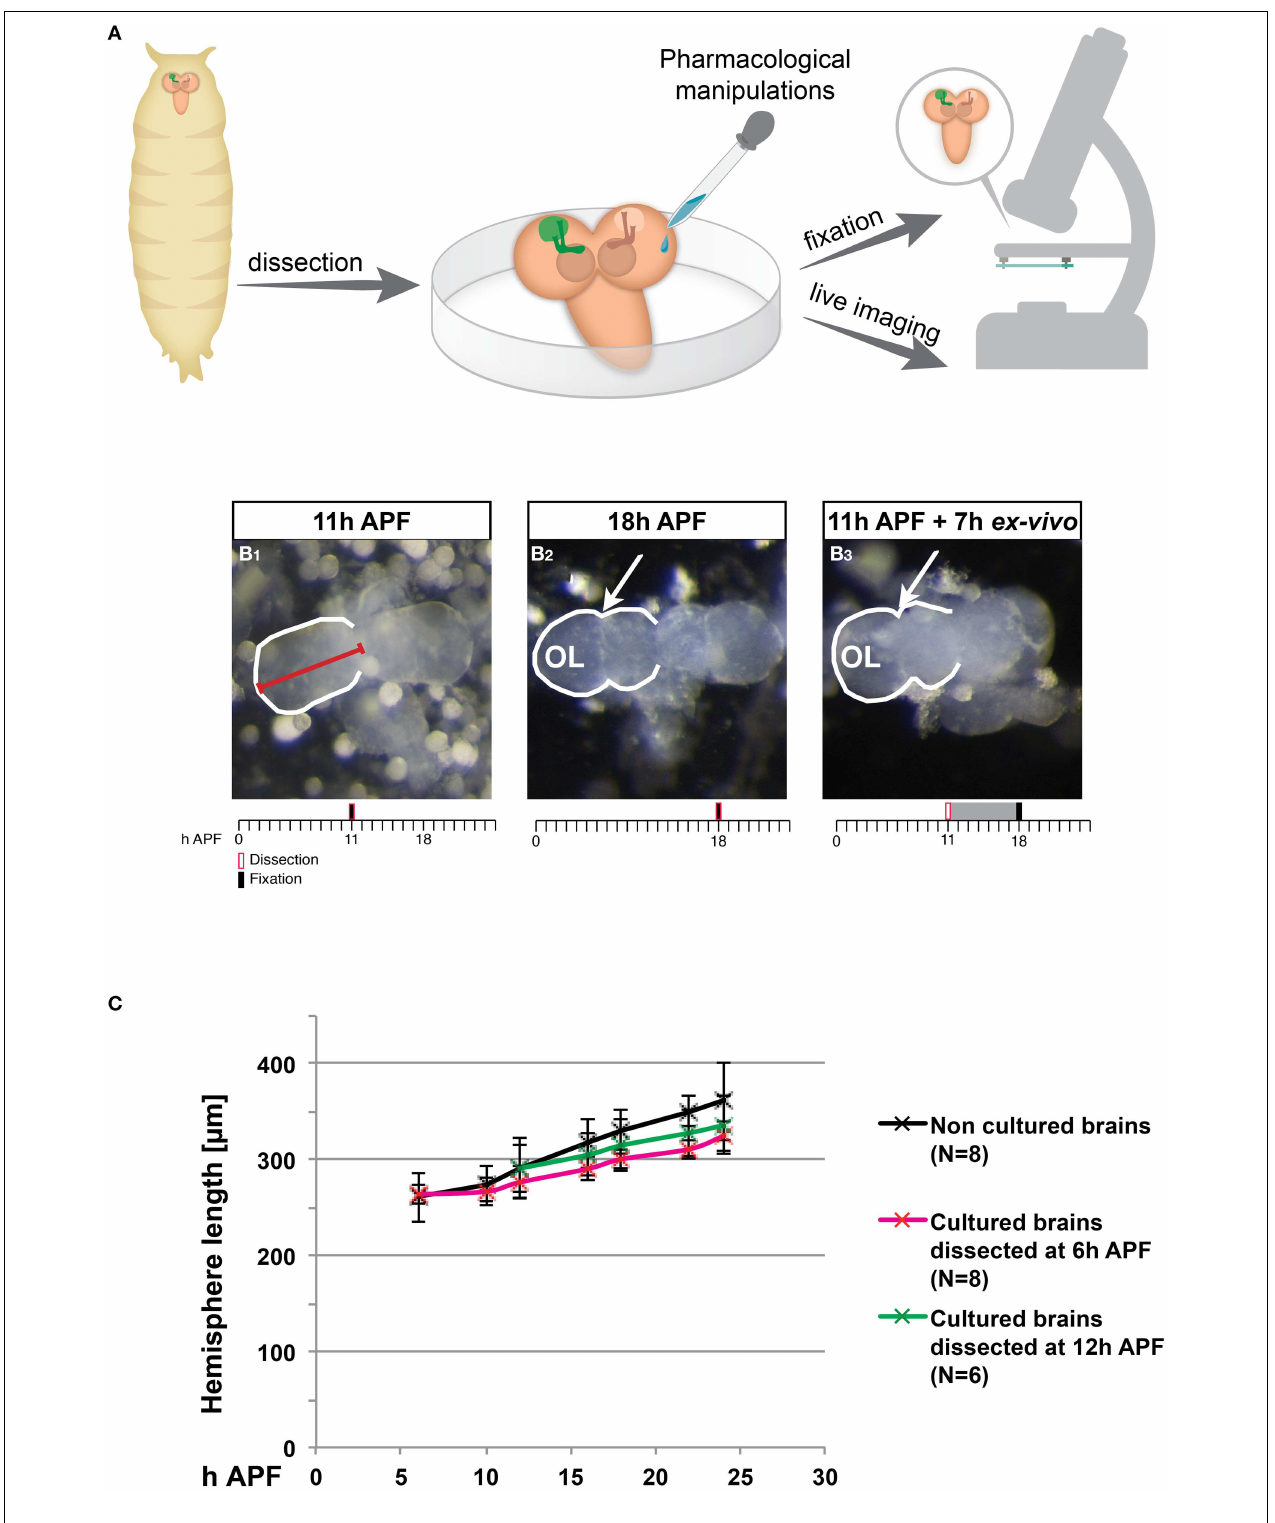
FIGURE 1 | Ex vivo cultured brains undergo morphological changes that are similar to normal development. (A) Scheme of the ex vivo culturing procedure. Brains were dissected from pupae at various developmental times and cultured, at which time they could have been